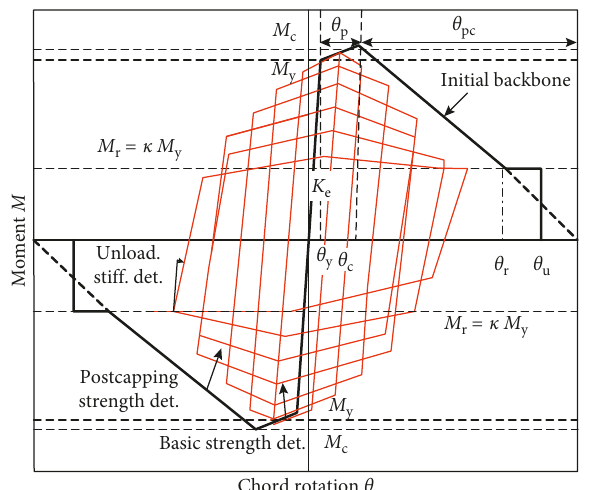
Figure 3: The Modified Ibarra-Medina-Krawinkler Deterioration Model [22].